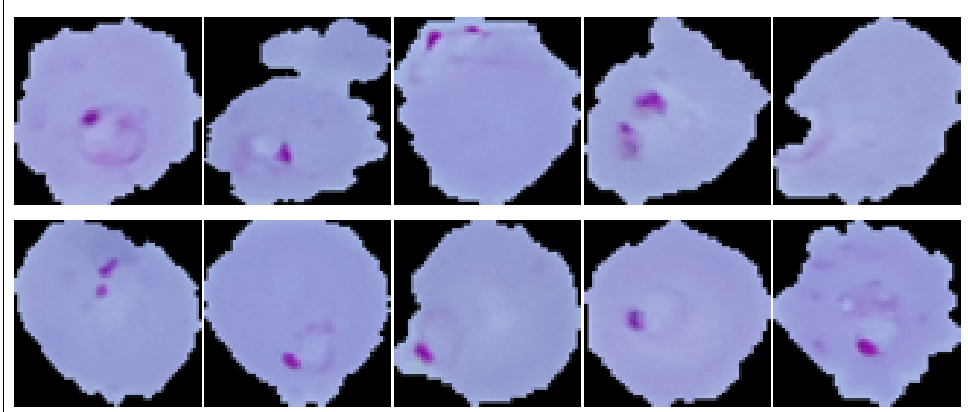
Figure 1. Infected cell images.